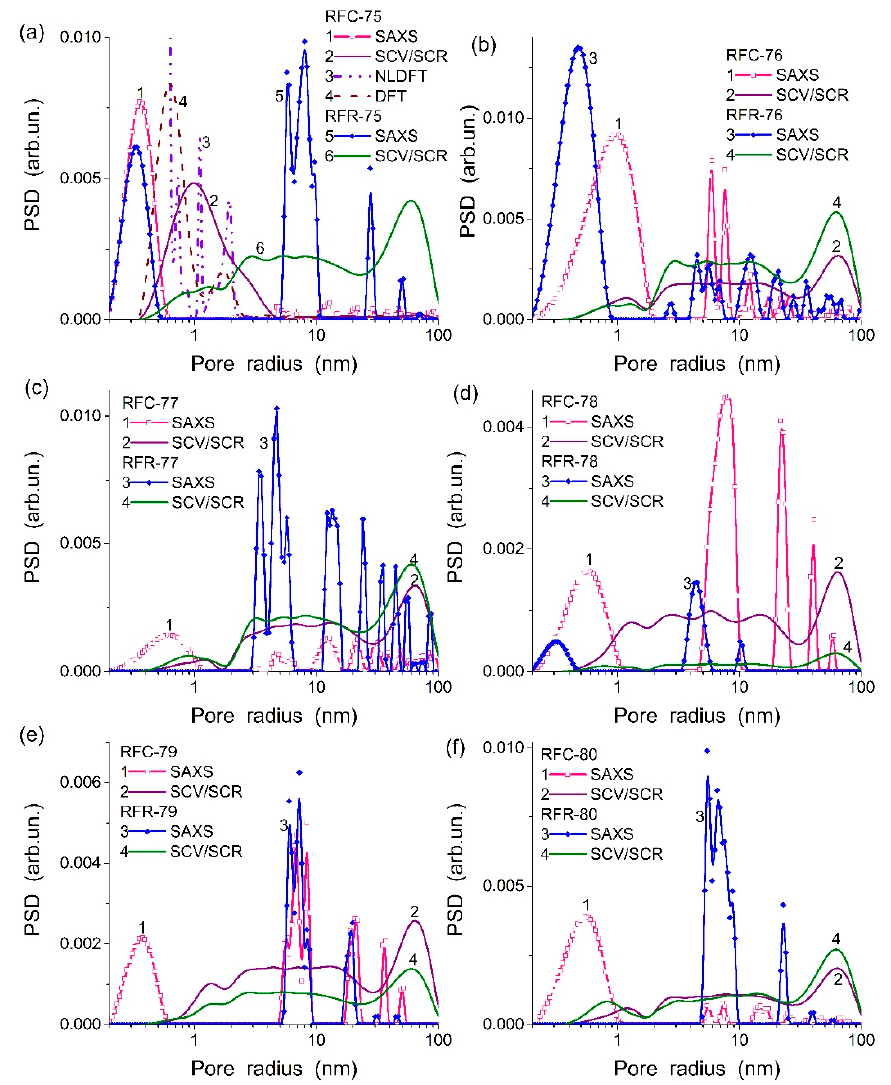
Figure 1. Pore size distributions calculated using nitrogen adsorption–desorption isotherms (using (SCV/SCR), nonlocal density functional theory (NLDFT) and (DFT) methods) and small angle X-ray scattering (SAXS) data for ( a ) RFR-75 and RFC75, ( b ) RFR-76 and RFC76, ( c ) RFR-77 and RFC-77, ( d ) RFR-78 and RFC-78, ( e ) RFR79 and RFC-79, and ( f ) RFR-80 and RFC-80.